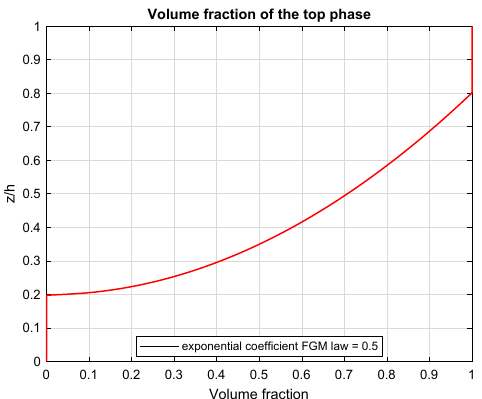
Figure 2. First benchmark, volume fraction of the ceramic phase for a simply supported sandwich square plate with FGM ( p = 0.5)